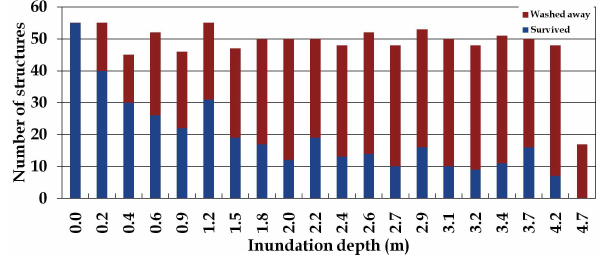
Fig. 8. Histogram of the numbers of washed-away and survived structures in terms of inundation depth range within the tsunami inundation zone. Each inundation depth range is determined by ex- ploring a range that includes approximately 50